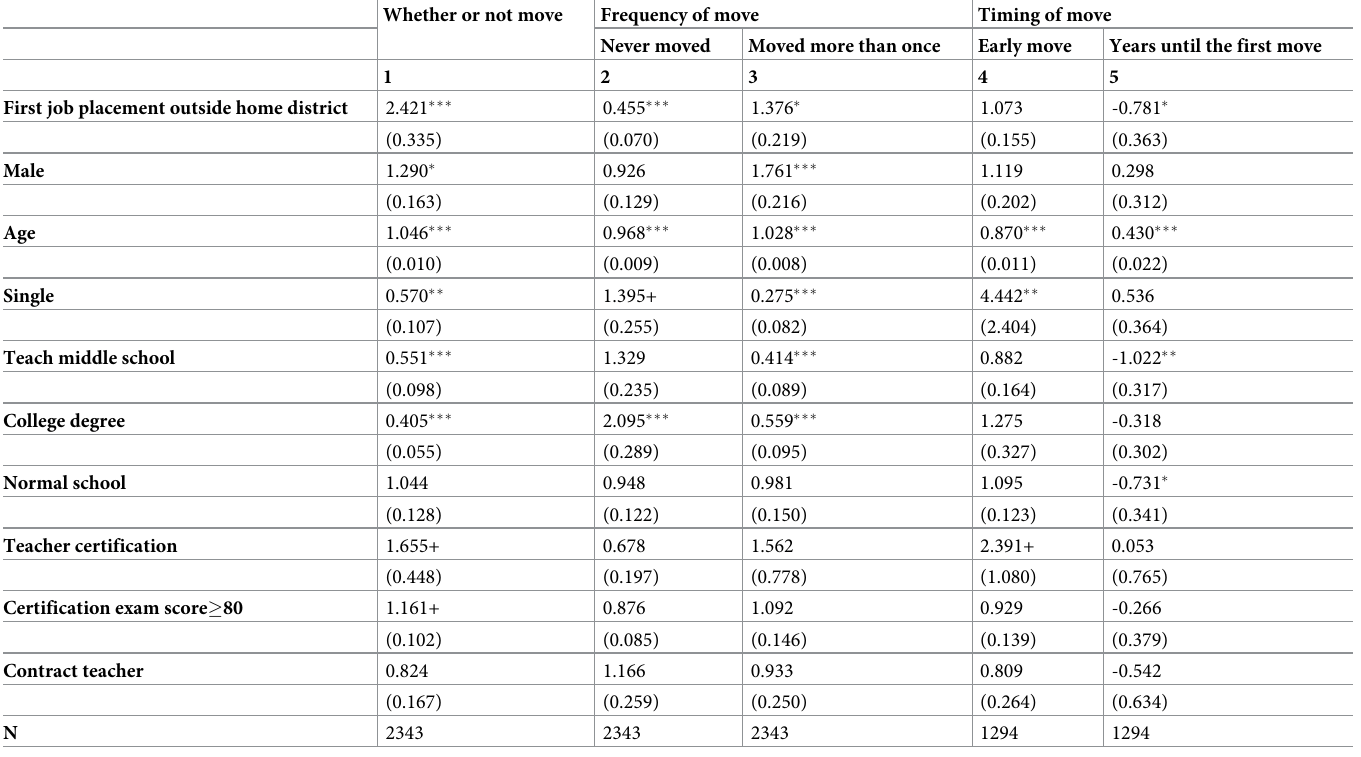
Table 4. Estimation results of the relationship between first job placement and teacher mobility